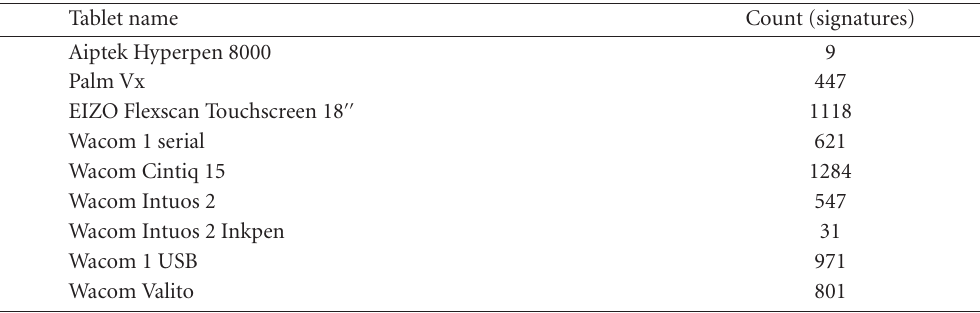
Table 6: Test set size of the extended database by tablet type.